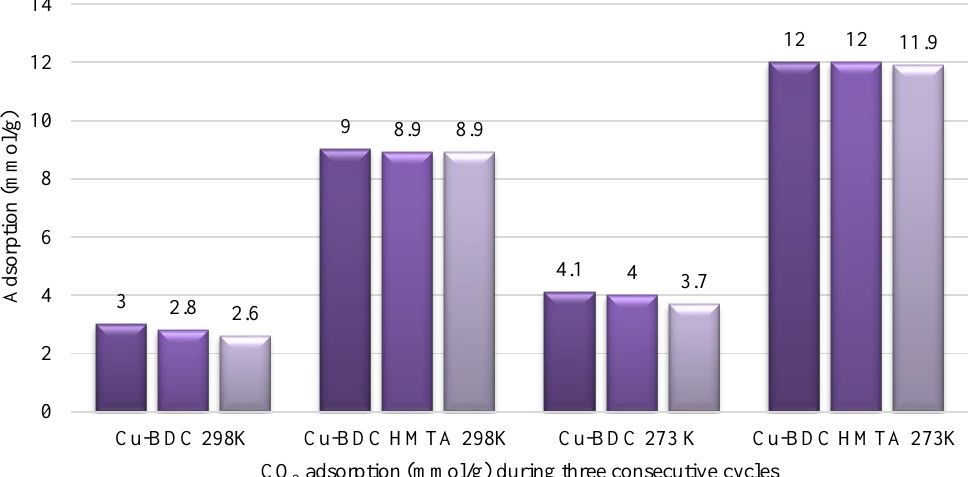
Figure 8. CO 2 adsorption in mmol / g calculated at 14 bar for Cu-BDC and Cu-BDC ⊃ HMTA at 273 K and 298 K as shown.